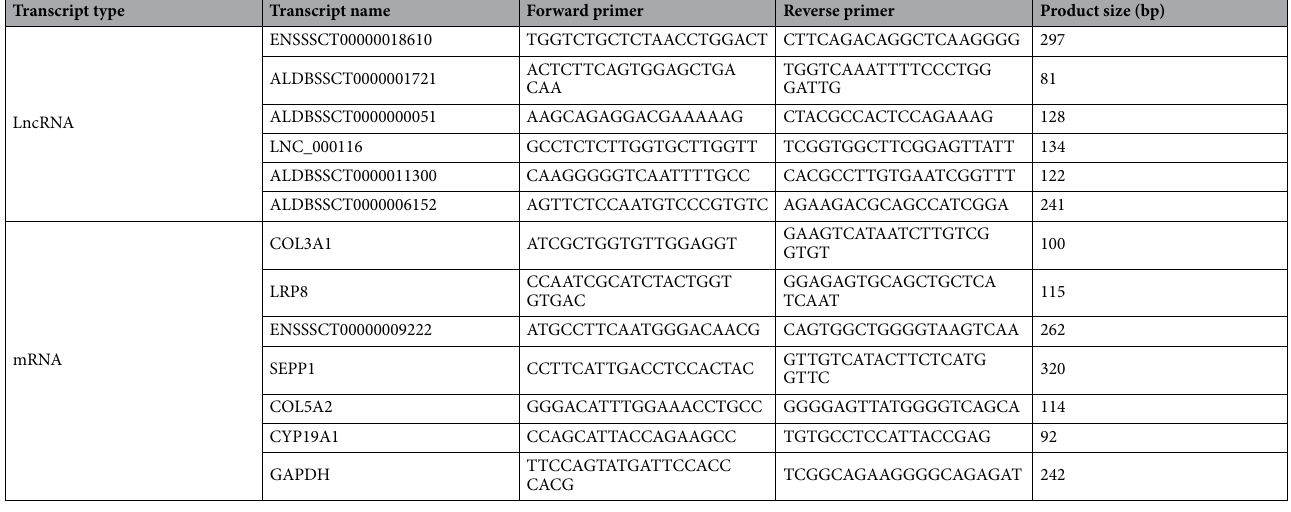
Table 3. The specific primers for